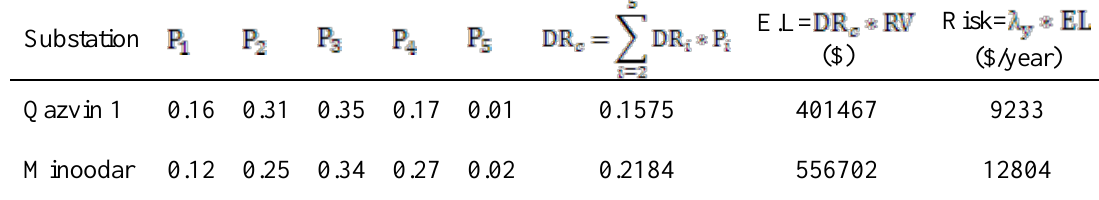
Table 15. The evaluation of economic loss and existing risk for the anchored low-voltage power